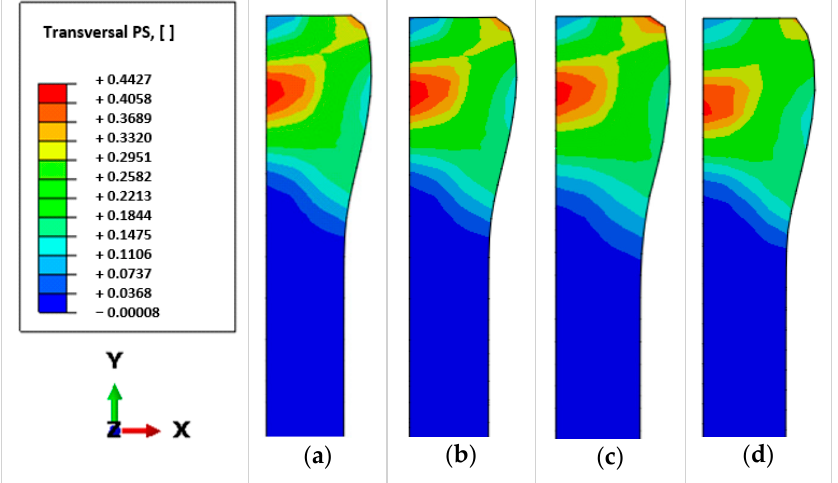
Figure 11. Transverse PS distribution on the inspection plane: ( a ) large scale implicit transient model (control model); ( b ) short implicit transient model; ( c ) short explicit transient model; ( d ) Eulerian steady-state model.